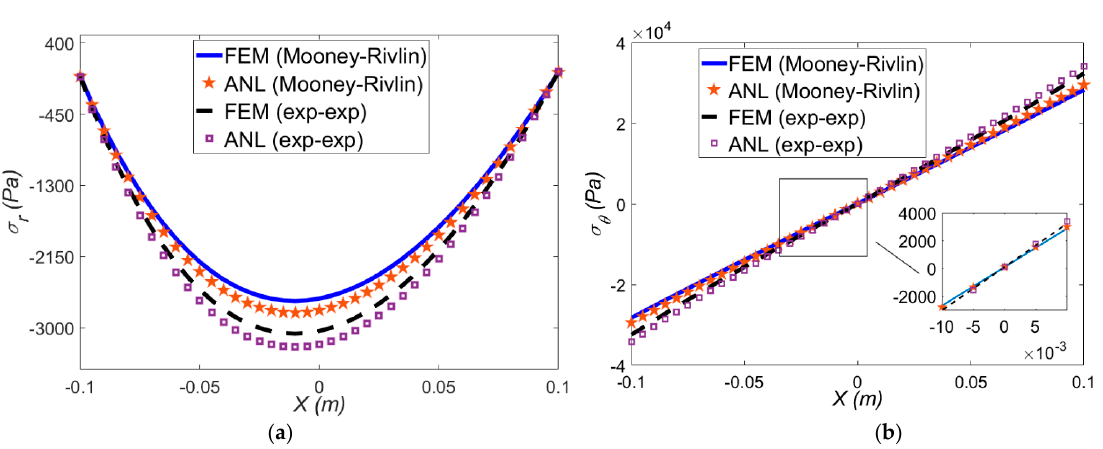
Figure 4. Variation of analytical and FEM ( a ) radial; ( b ) hoop stress through the beam thickness under ρ = 0.5 m and Δ T = 50 °C for two types of strain energy functions.